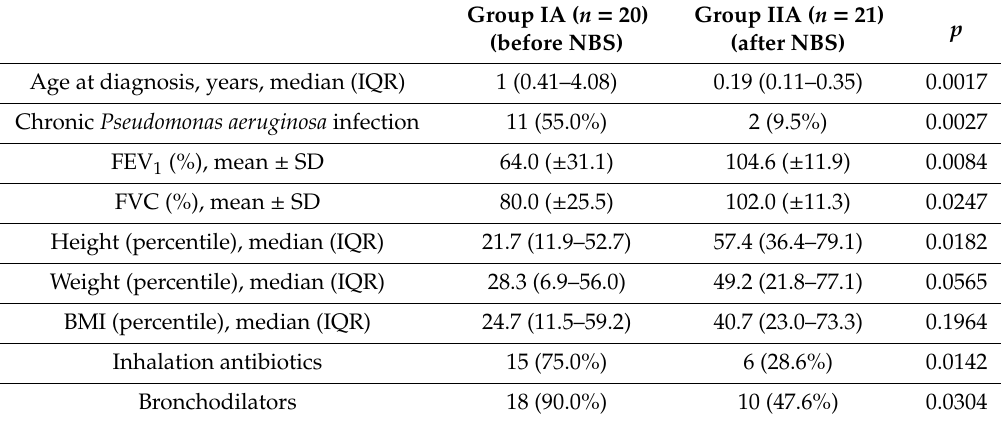
Table 3. Characteristics of the homozygotes c.1521_1523delCTT (F508del) in subgroups IA and